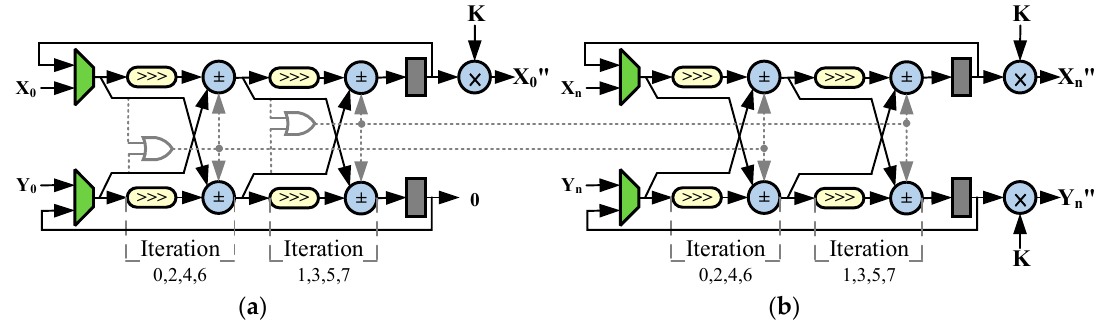
Figure 14. CORDIC unit designs. ( a ) vector mode; ( b ) rotation mode.